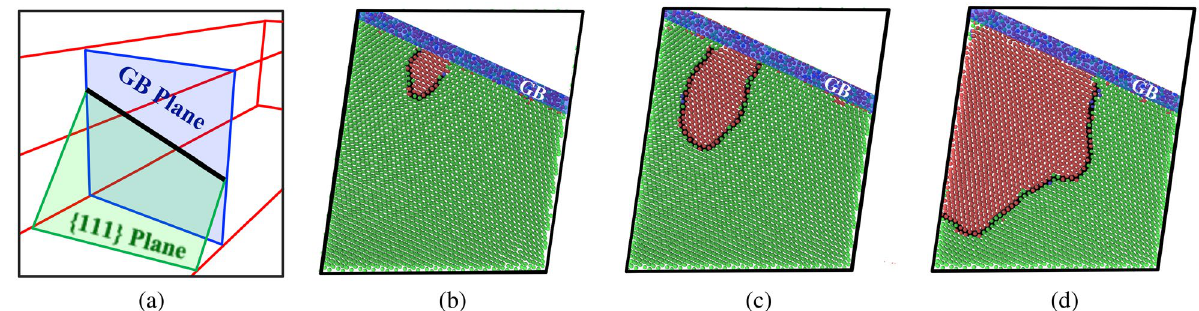
Figure 5. For the bicrystal with a (cid:31) 9 [110] STGB: (a) a schematic representation showing the GB plane (blue) and { 111 } plane (green); and (b–d) views along the normal to the { 111 } plane depicting the nucleation and growth of a 1/6 (cid:31) 112 (cid:30) dislocation at a nominal strain of (b) ǫ = 5.0% , (c) ǫ = 5.4% , and (d) ǫ = 5.5% . In (b)– (d) , the black line represents the partial dislocation that demarcates regions of FCC (green) from HCP (red) atoms. The shaded region in blue denotes the intersection region of the GB and { 111 } plane.